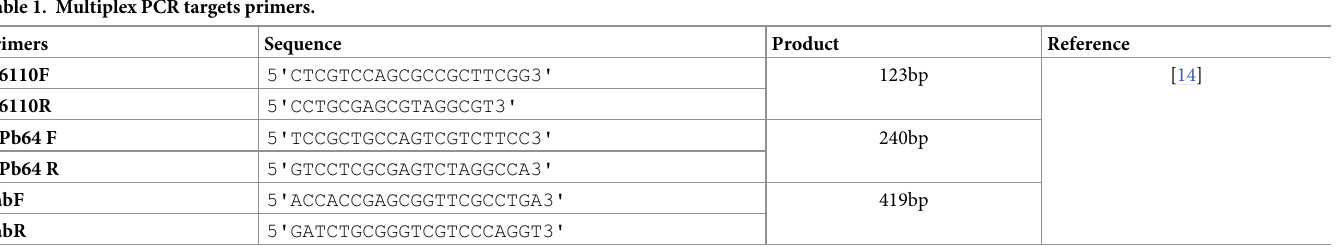
Table 1. Multiplex PCR targets